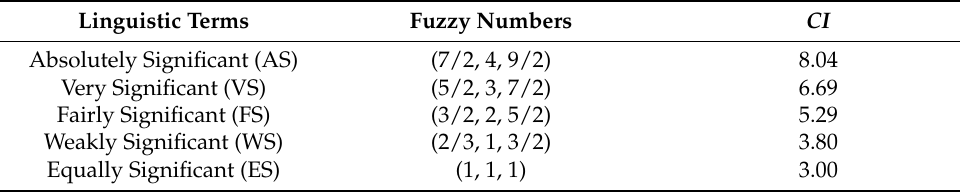
Table 2. Linguistic Terms and Fuzzy Numbers